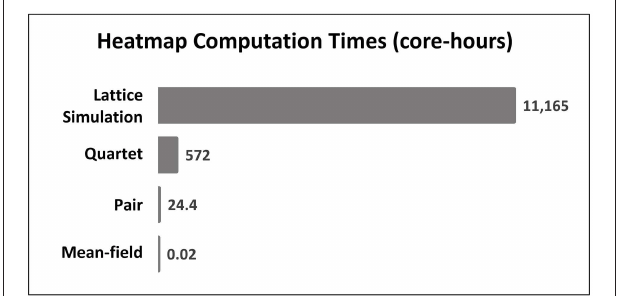
FIGURE 12 | Computation times, measured in CPU core-hours, required to generated the “heatmaps” in Figure 10 for each method. Each bar represents the total computational work required to run the respective model for 500,000 update steps, repeatedly for 10,000 parameter combinations. Note that times are “real CPU” times for a single-core process, and do not include any additional overhead time which may have been incurred by the operating system or job scheduling